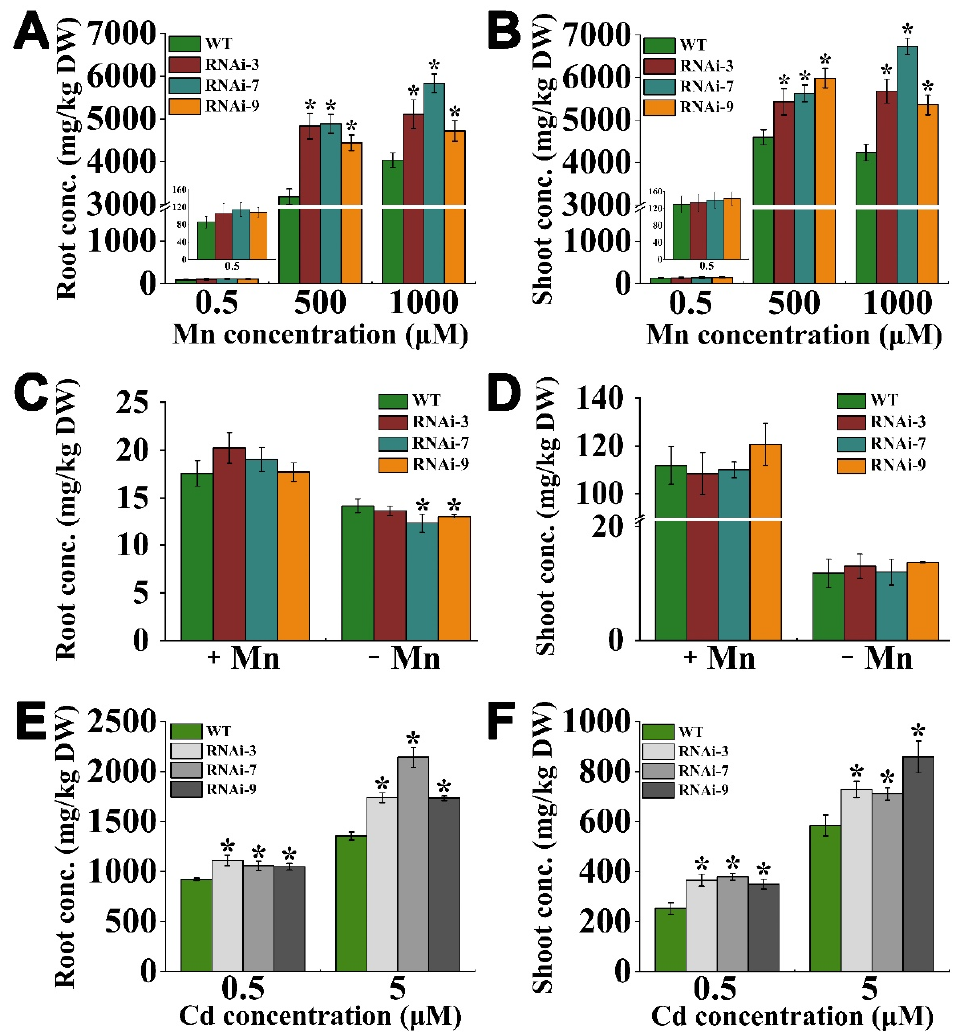
Figure 4. Accumulation of Mn and Cd in tRNAi and wild-type (WT) rice under Mn and Cd stress. Two week-old young rice plants were hydroponically grown with 0.5 (normal), 500, and 1000 μ M Mn and 0, 0.5, and 5 μ M Cd for 14 d, or under Mn deficiency for 30 d. ( A , B ) Mn concentrations in roots and shoots exposed to excessive Mn supply conditions. ( C , D ) Mn concentrations in roots and shoot under Mn deficiency (+Mn: 0.5 μ M). ( E , F ) Cd concentrations in roots and shoots. Error bars indicate the means ± standard deviations of independent biological replicates. Asterisks indicate that the mean values of three replicates are significantly different between WT and RNAi lines ( p < 0.05).